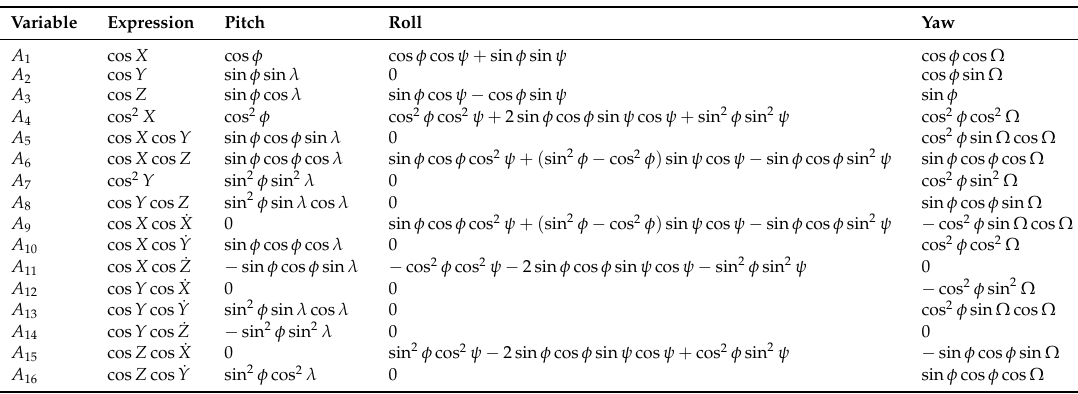
Table 2. Model variables in the east